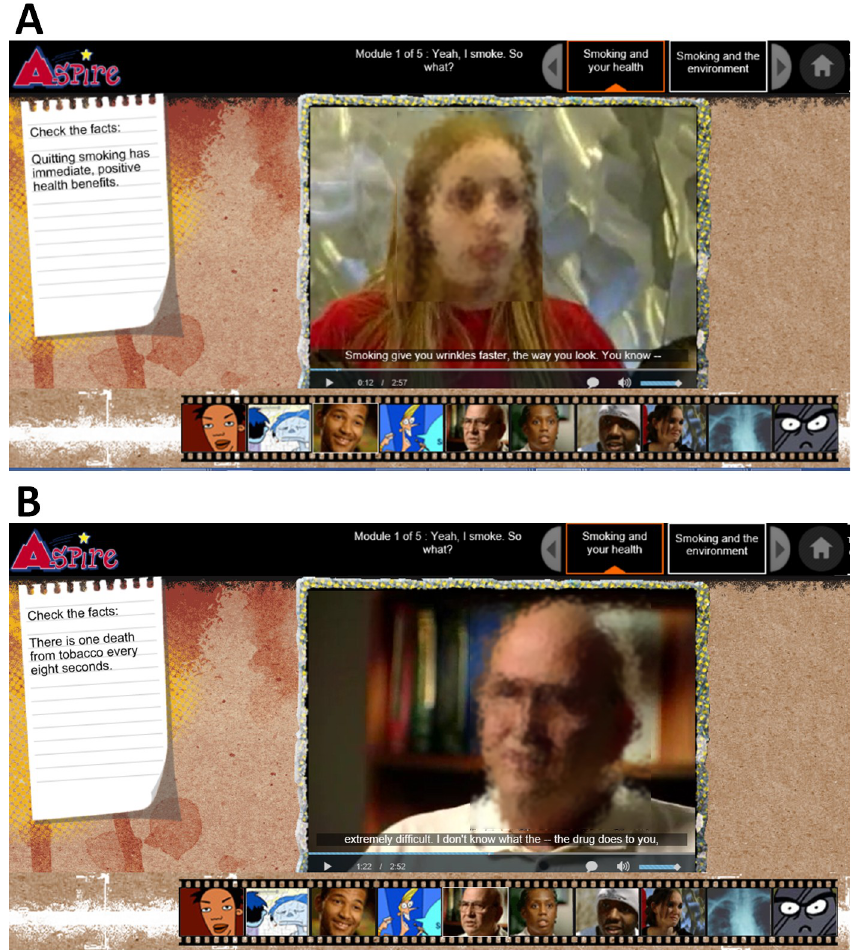
Fig 4. Examples of videos in ASPIRE. In this figure, (a) adolescents and (b) adults are sharing their experience with smoking. These videos are part of the ASPIRE material. They do not present participants in the study. Faces have been